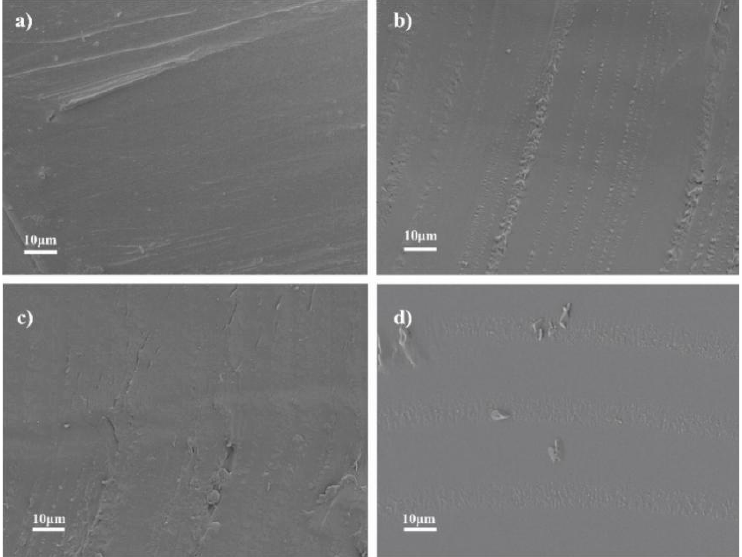
Figure 2. SEM images of ( a ) PET, ( b ) 0.6MIL − PET, ( c ) P − PET, ( d ) 0.6MIL − P − PET.